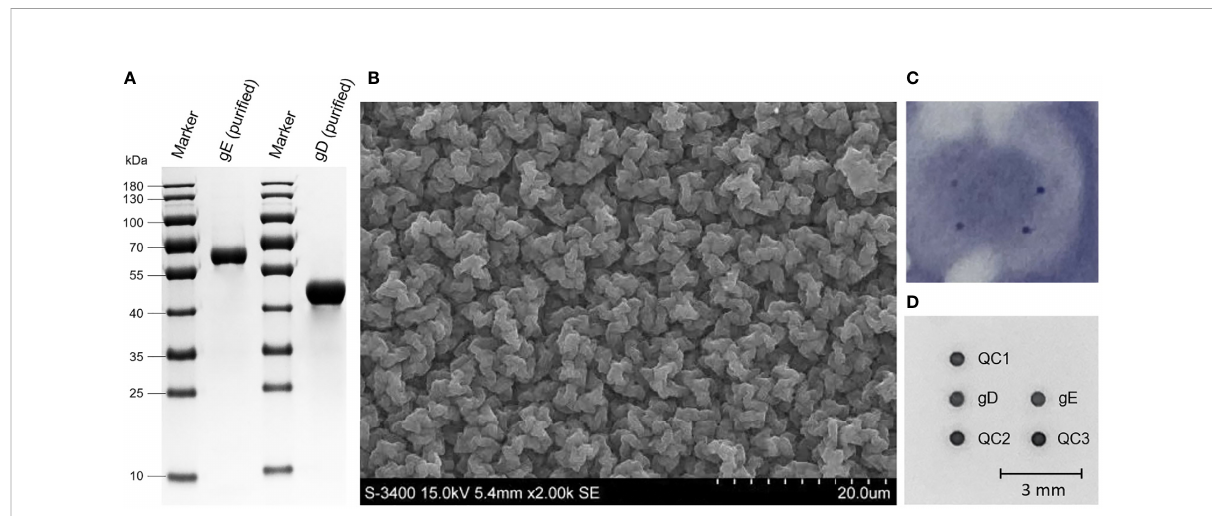
FIGURE 2 Expression of PRV gD and gE and the Ab detection based on the PDMS membrane. (A) SDS-PAGE analysis of the puri fi ed gD and gE proteins expressed in Sf9 cells after size exclusion chromatography. (B) Scanning electron microscopy of the PDMS membrane. (C) Abs detection results of gD and gE in the nitrocellulose membrane. (D) Abs detection results of gD and gE in the PDMS membrane. mm,